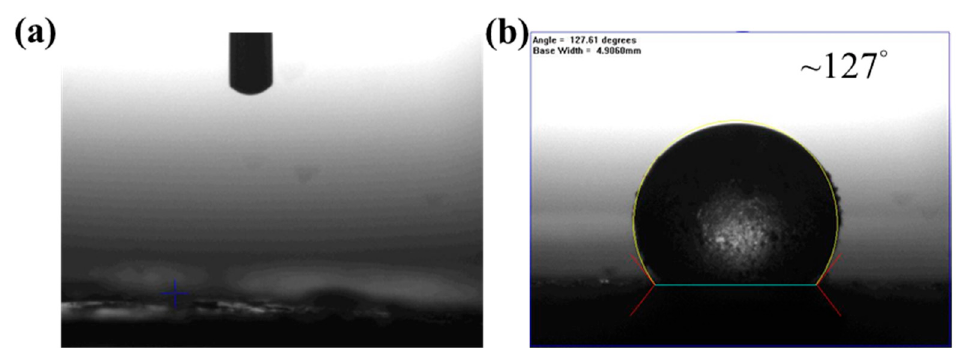
Figure 5. Contact angle of the water droplets for the ( a ) hydrophilic MSPs (A1, A2, and A3). (un-detectable) and the ( b ) hydrophobic MSPs (M1 and